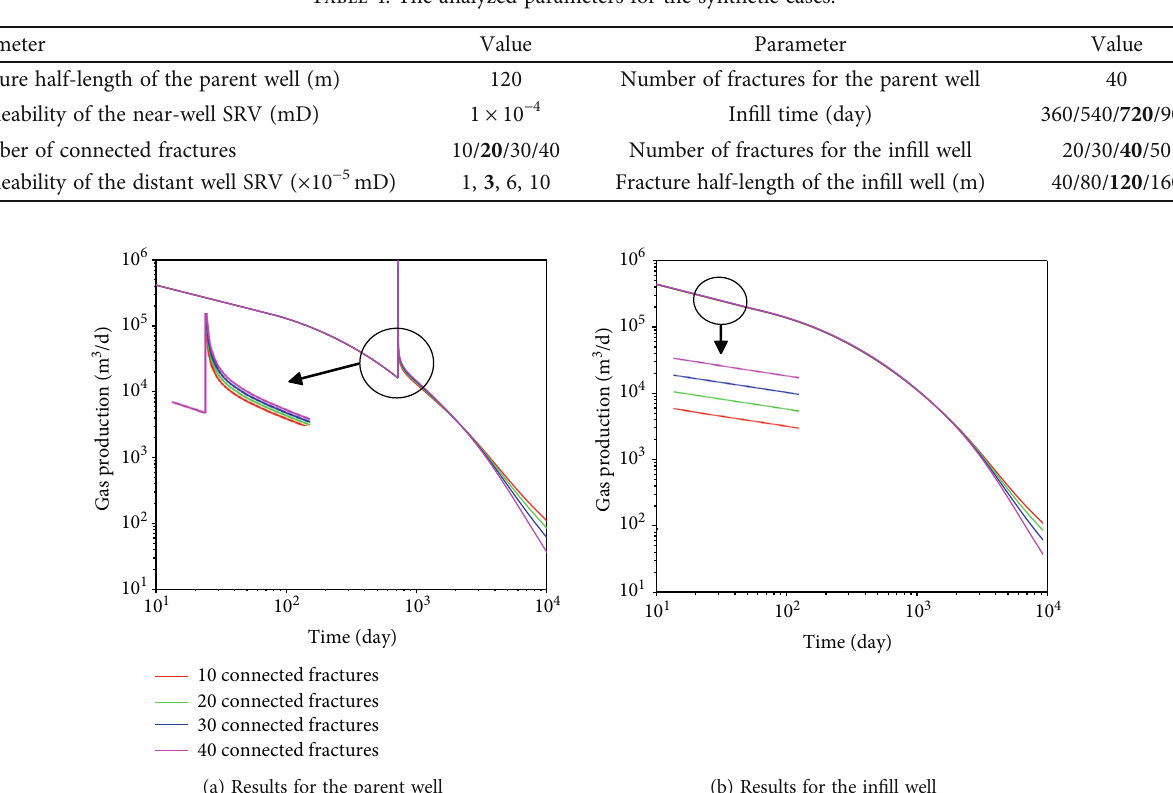
Figure 6: The e ff ects of connected fracture numbers on the gas production of both parent and in fi ll